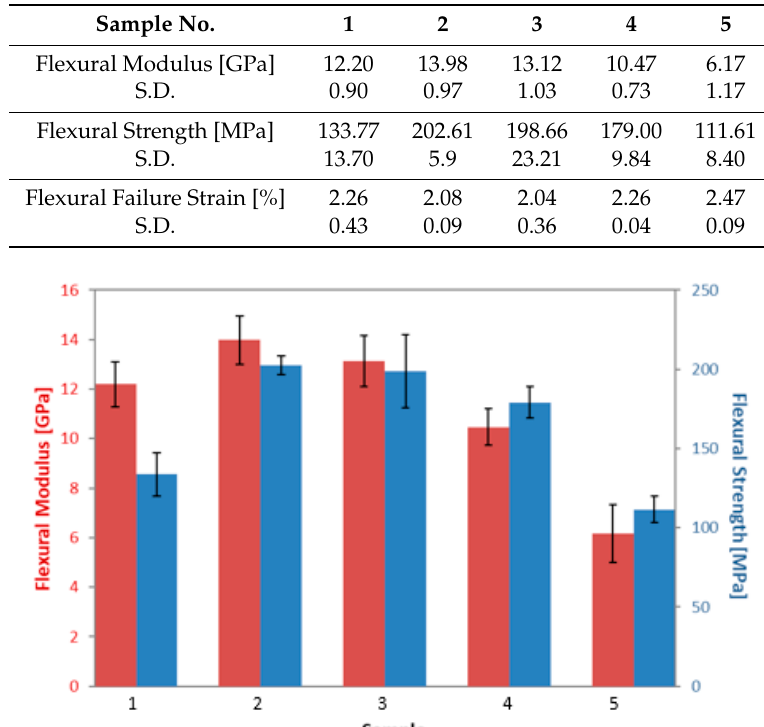
Table 4. Flexural strength, flexural modulus, and strain at failure with standard deviations of all tested samples.